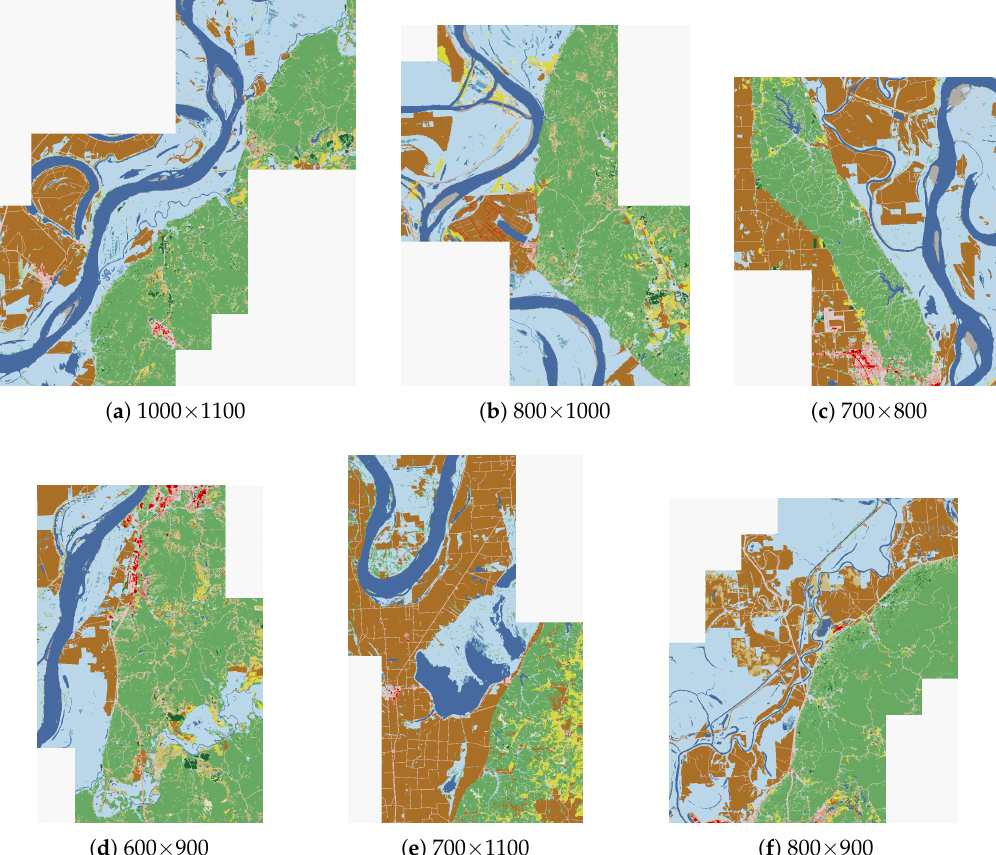
Figure 13. Top six retrieval results of reference II acquired by the use of the method proposed in [28].